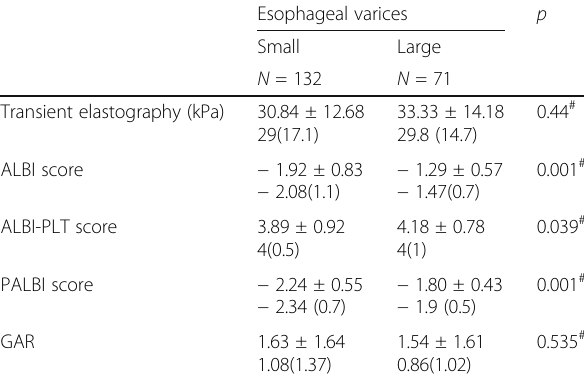
Table 2 Comparison of TE, ALBI, ALBI-PLT, and PALBI in patients with small and large esophageal varices